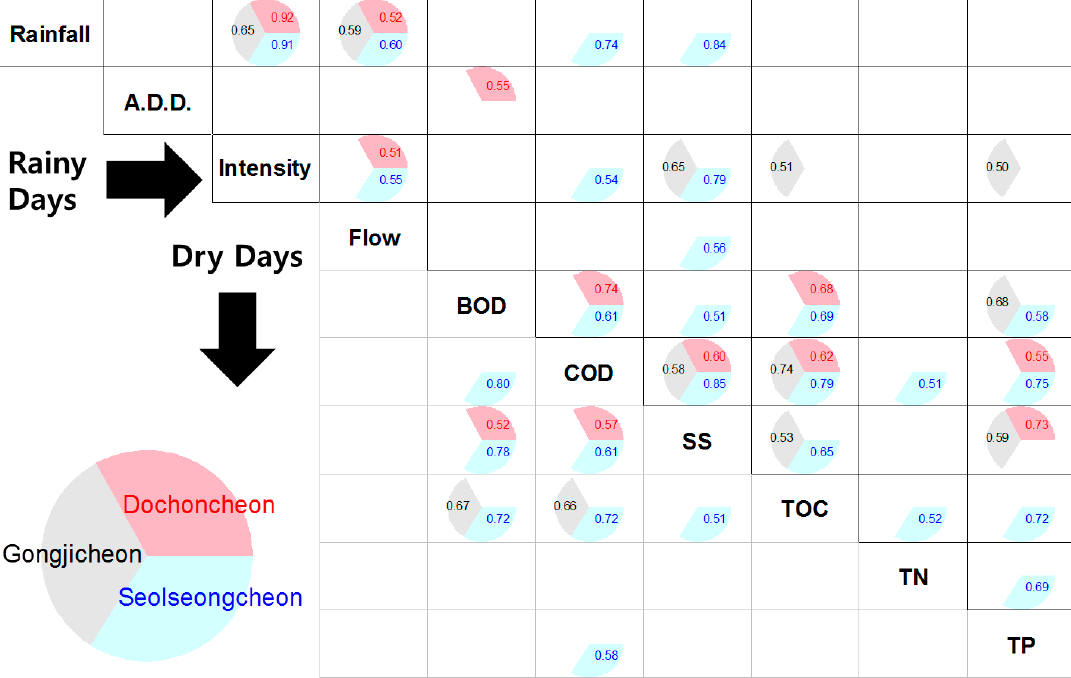
Table 5. Eigenvalues and proportion of variance explained by principal component analysis.